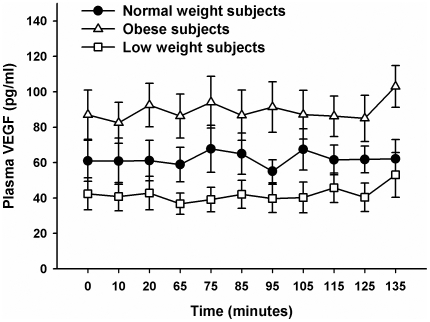
Plasma VEGF concentrations during the experiment.Plasma VEGF concentrations (mean values ± SEM) at baseline and during the euglycemic clamp procedure. Time point 65 until time point 105 was included in the calculation of the ISI values.